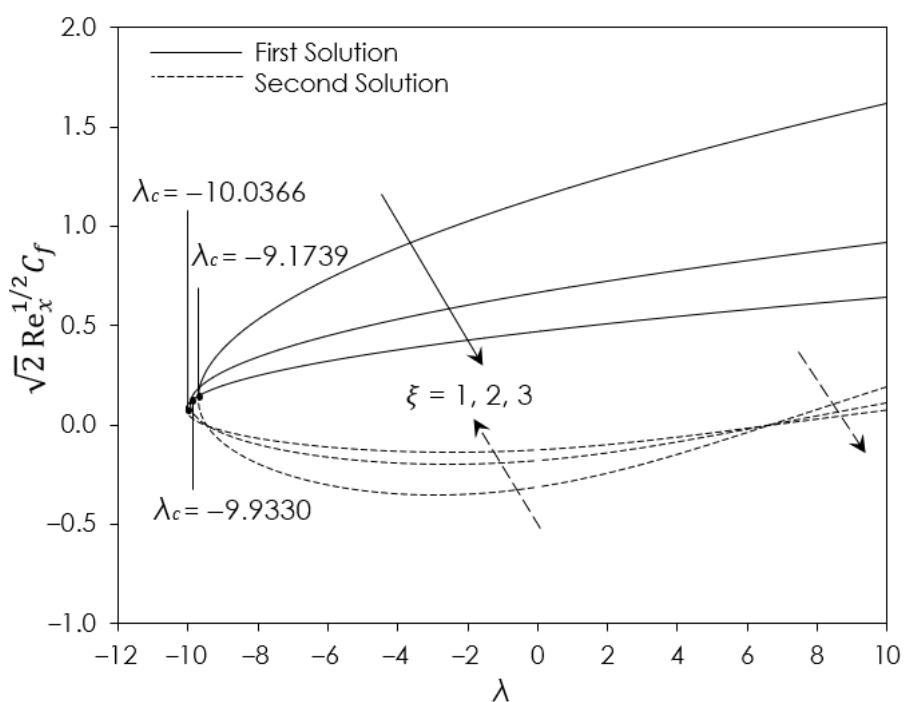
√ Figure 6. Variation of 2 Re 1/2 x C f for different values of ξ . Figure 6. Variation of √2 Re 𝑥1/2 𝐶 𝑓 for different values of 𝜉 . √ Table 4. 2 Re 1/2 x C f values for various values of c . Table 4. √2 Re 𝑥1/2 𝐶 𝑓 values for various values of c.